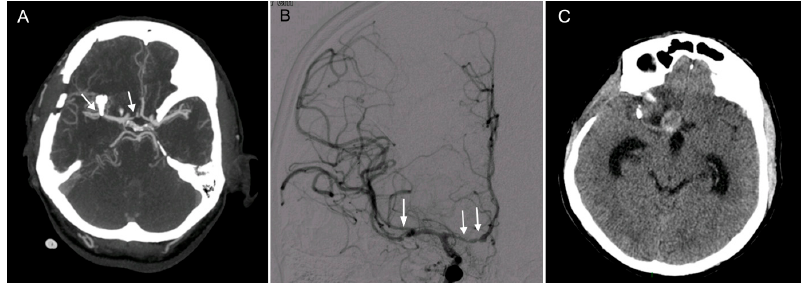
Figure 1. Clipping of a ruptured middle cerebral artery (MCA) aneurysm complicated in the postoperative course by vasospasm and the development of a pseudoaneurysm (PSA). ( A ). A computed tomography angiography (CTA) performed on the first postoperative day shows clips after treating an MCA aneurysm (left arrow) and a narrowing of the right A1 segment (right arrow), which eventually led to later complications. ( B ). Postoperatively, the patient developed a severe vasospasm (white arrows) which was successfully treated including an intra-arterial pharmacological angioplasty with milrinone. ( C ). Brain computed tomography (CT) performed 3 months later presenting hydrocephalus and a suspicious PSA of the distal right A1